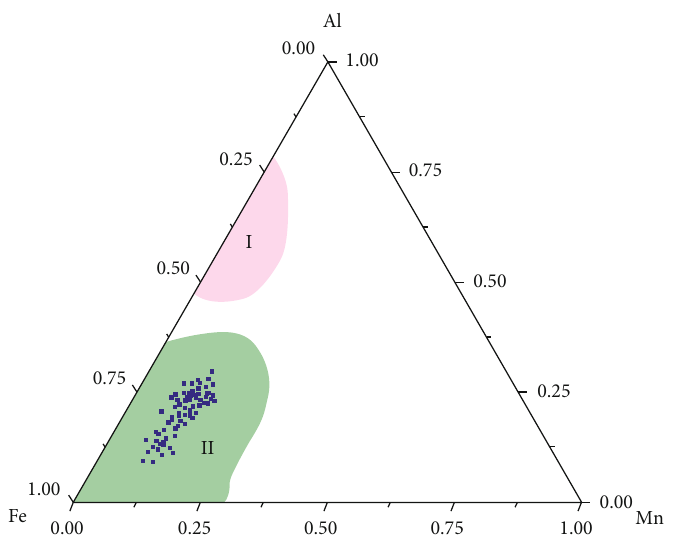
Figure 4: The Al-Fe-Mn triangular graph is used to analyze the siliceous mineral source in the segment with Si Cambrian Wangyinpu Formation. It is found that Si (see Figure 1 for the well location). I: bioorigin; II: hydrothermal